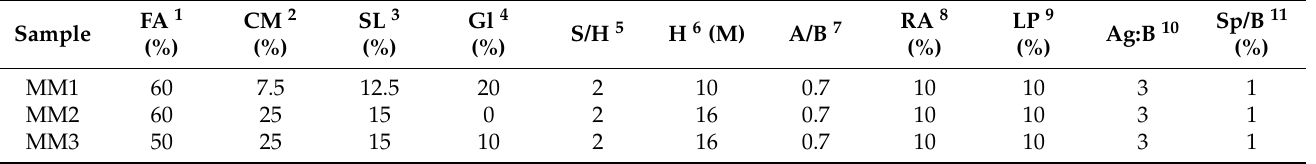
Table 3. Key material ratios of the first group of mortar